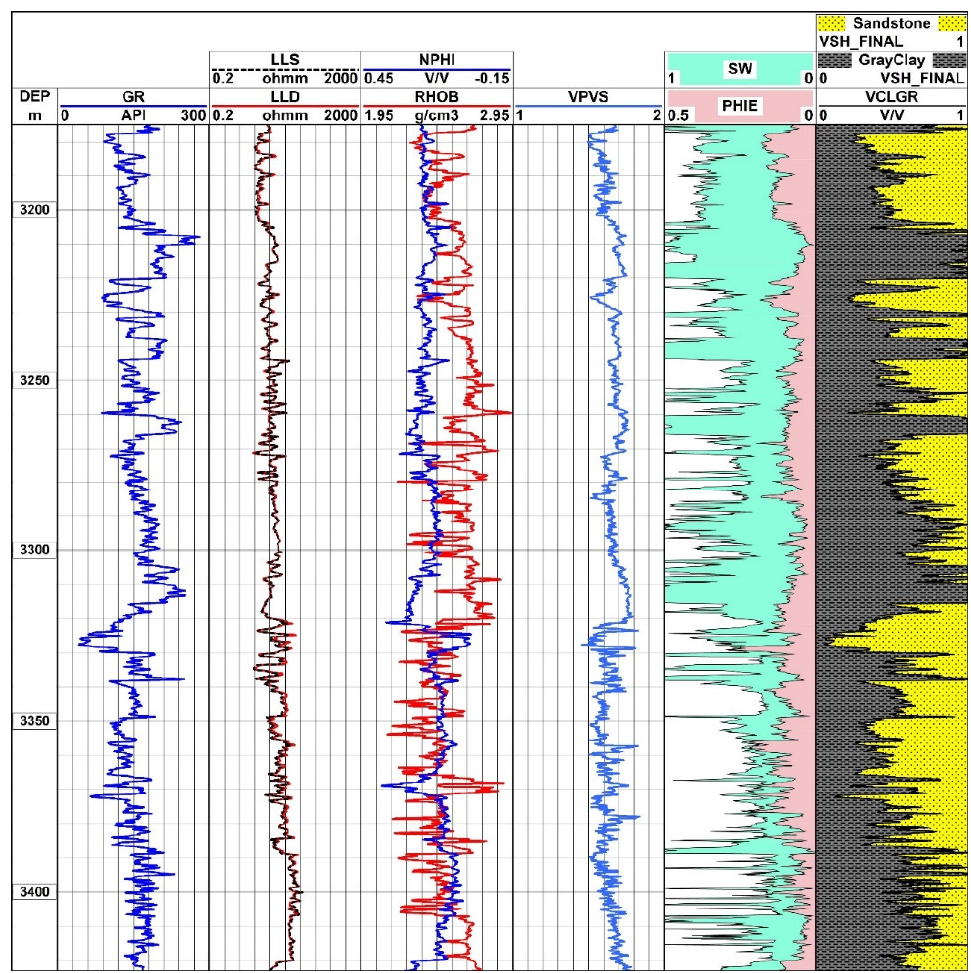
Figure 4. Well log data from Miano-07 well at targeted gas zone. The reservoir zones are within the Lower Goru formation. Table 1. Prediction of petrophysical parameters from chosen depth intervals of two wells in the Middle Indus